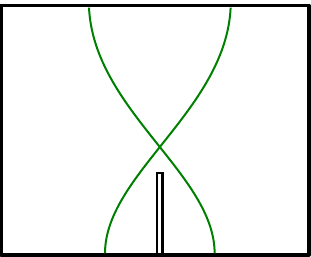
FIG. 7. A ϕ 2 flux and a ϕ 1 flux fuse with a minus sign, computed as a path integral over the pair of pants with an unavoidable domain-wall